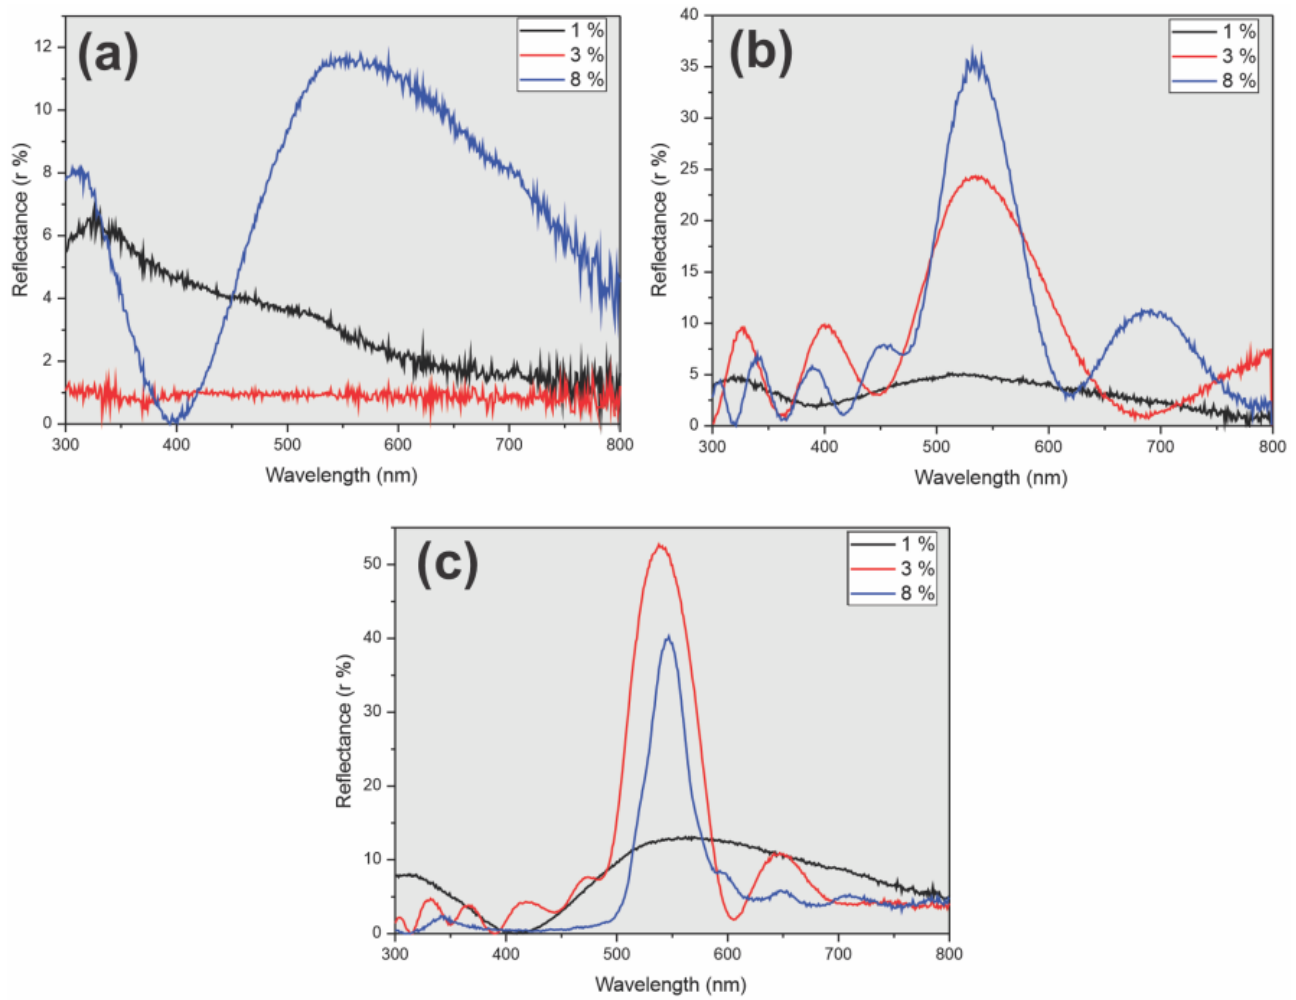
Figure 3. Reflectance spectra of colloidal crystals obtained at 15 ( a ), 1.66 ( b ), and 0.28 µ m/s ( c ). Figures 4 and 5 display a graphical representation of peak wavelength, maximum reflectance, and FWHM as a function of lifting speed and SP suspension